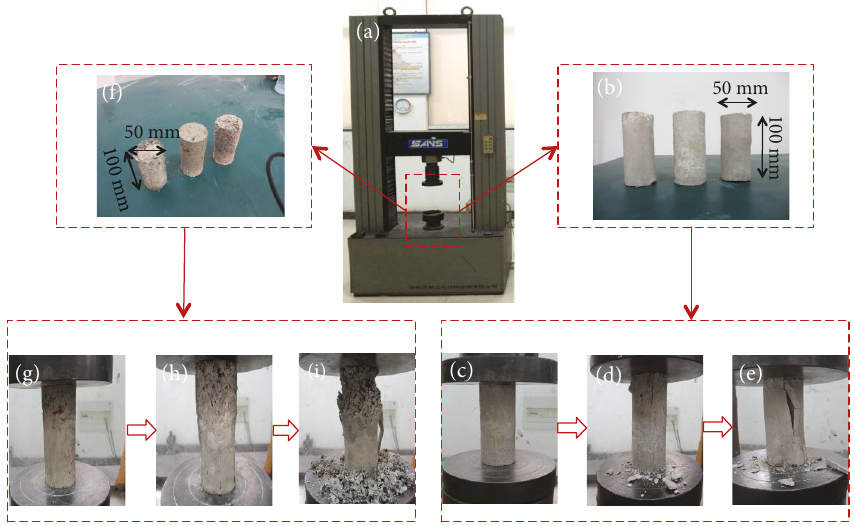
Figure 5: Compression test of induration of expandable material with high water content and induration of expandable material with high water content consolidated with coal masses: (a) uniaxial compression tester, (b) induration specimen of expandable material with high water content, (c – e) compression tests of expandable material with high water content, (f) induration specimen of expandable material with high water content consolidated with coal masses, and (g – i) compression test of induration of expandable material with high water content consolidated with coal masses.